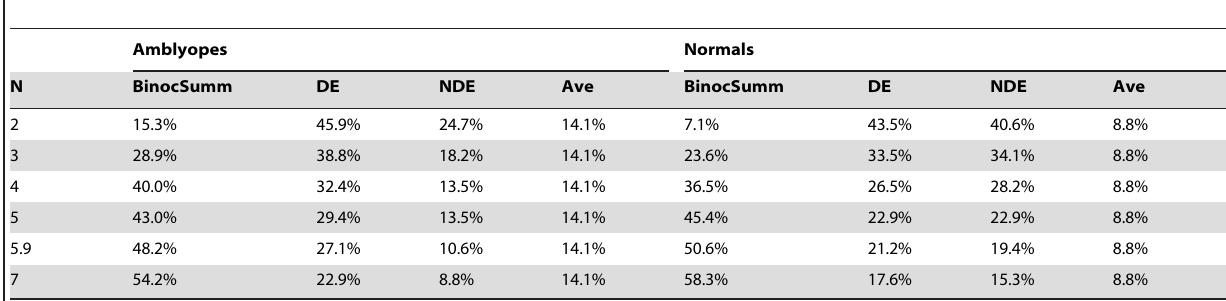
Table 2. Outcomes of modelling results at each location as a function of exponent (n).